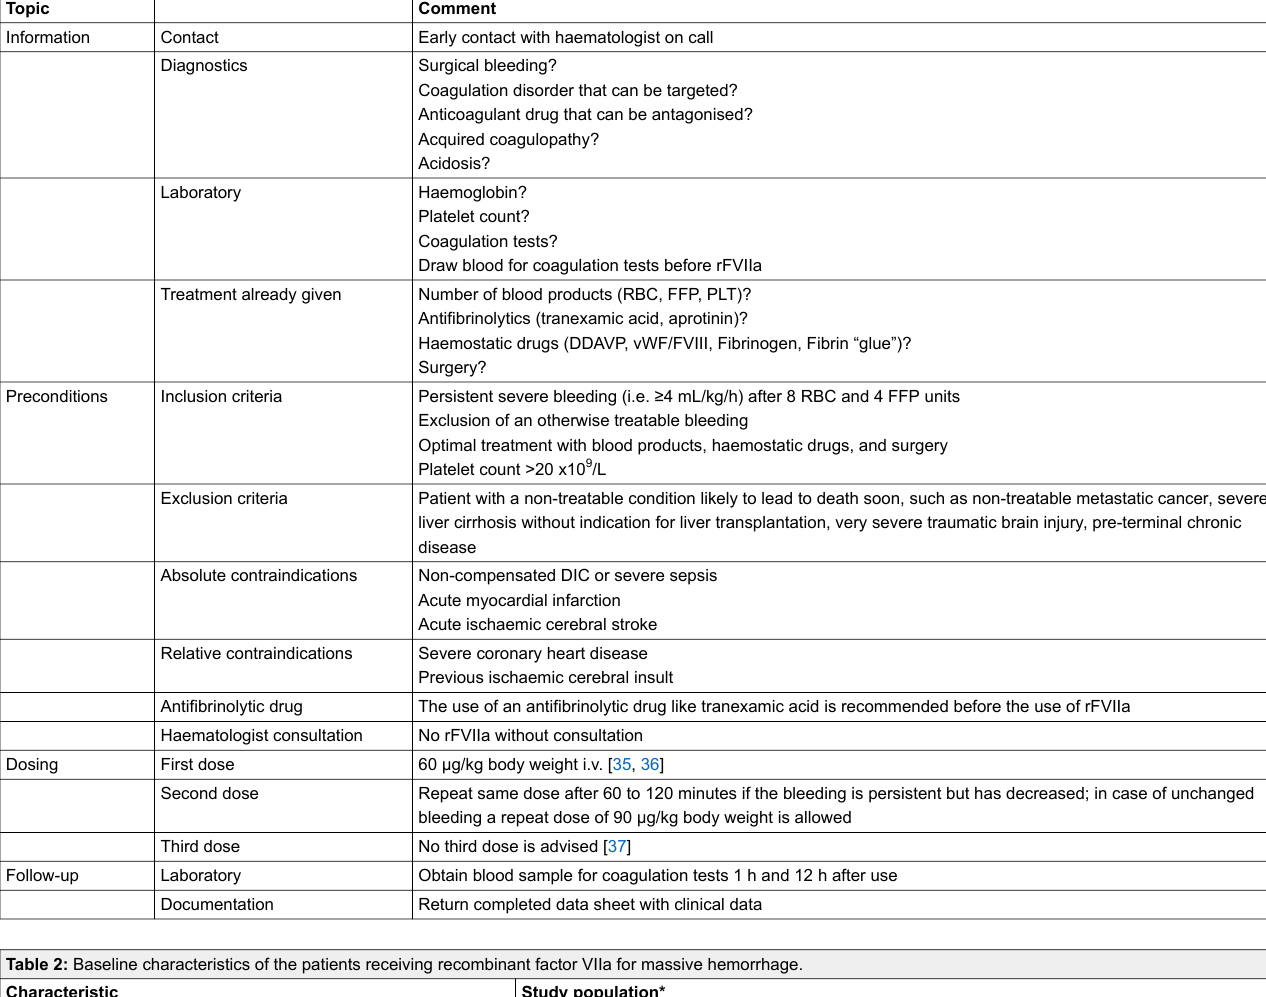
Table 2: Baseline characteristics of the patients receiving recombinant factor VIIa for massive hemorrhage. Characteristic Study population* Basic epidemiological